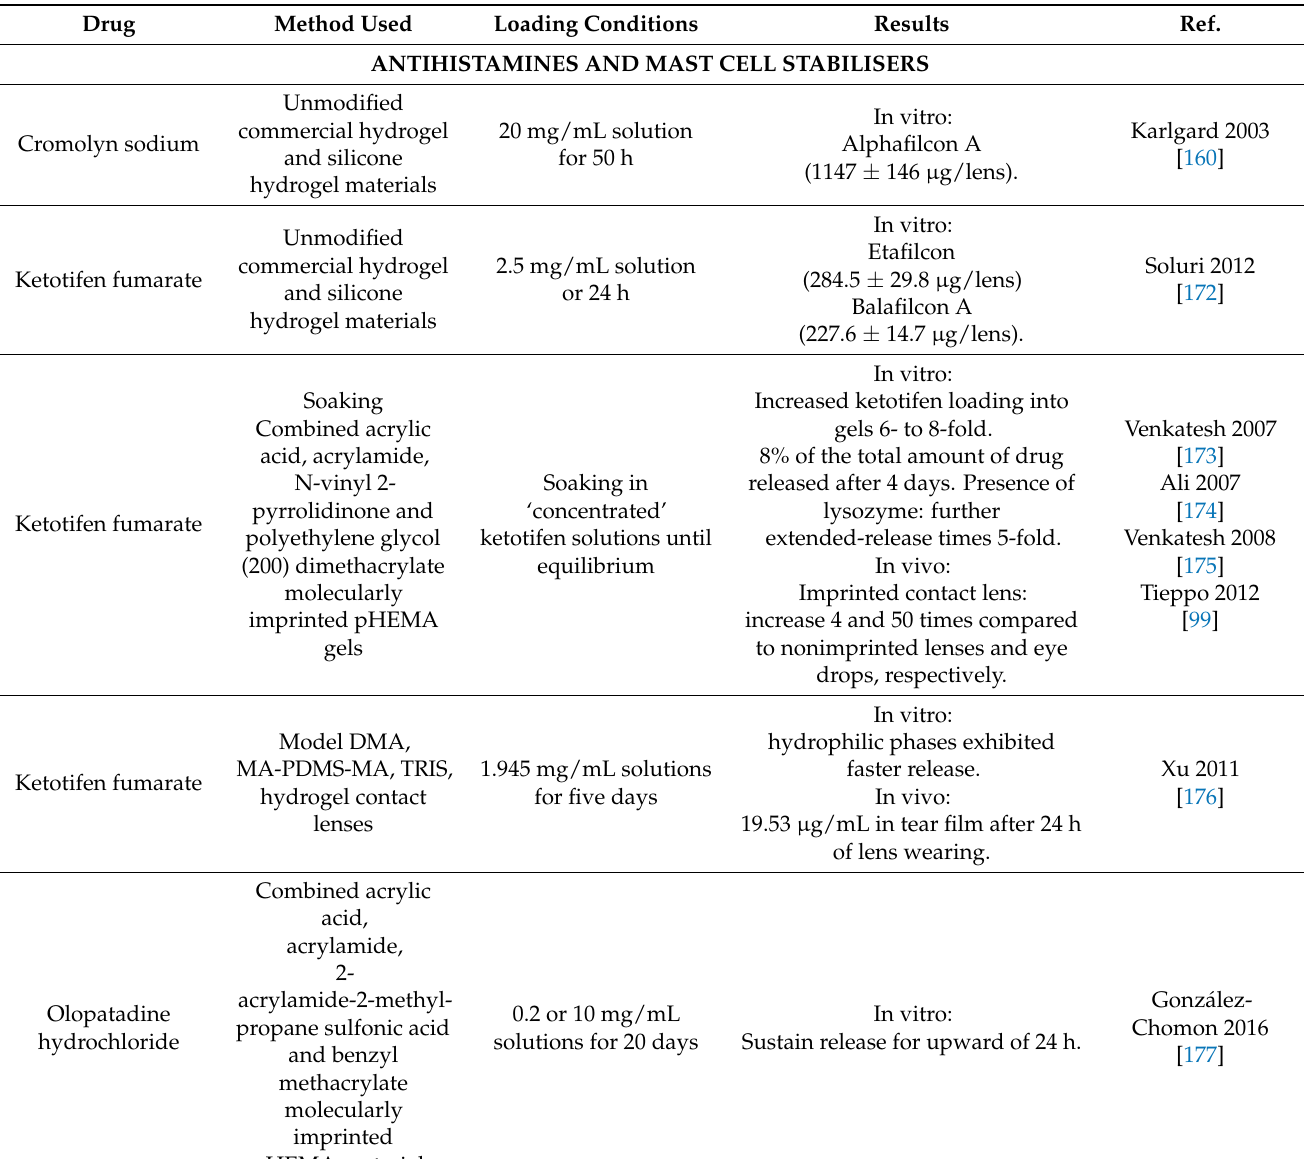
Table 5. Selected CL drug delivery experiments investigating anti-allergy agents [16,155]. Drug Results